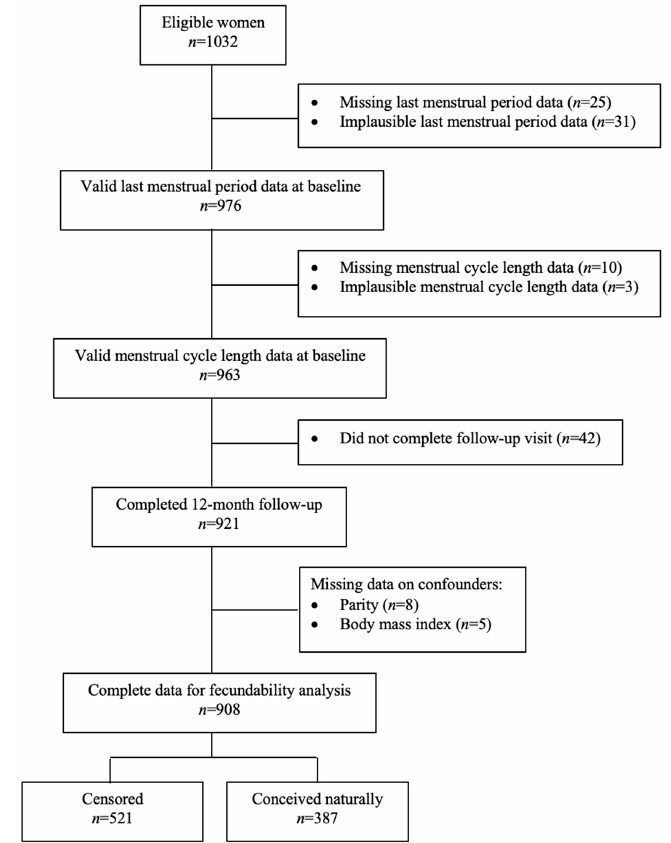
Figure 1. Flowchart showing women included in the present study. Table 1. Characteristics of women according to supplement intake status in the last 3 months from the S-PRESTO study, 2015–2018 ( n = 908). Characteristics